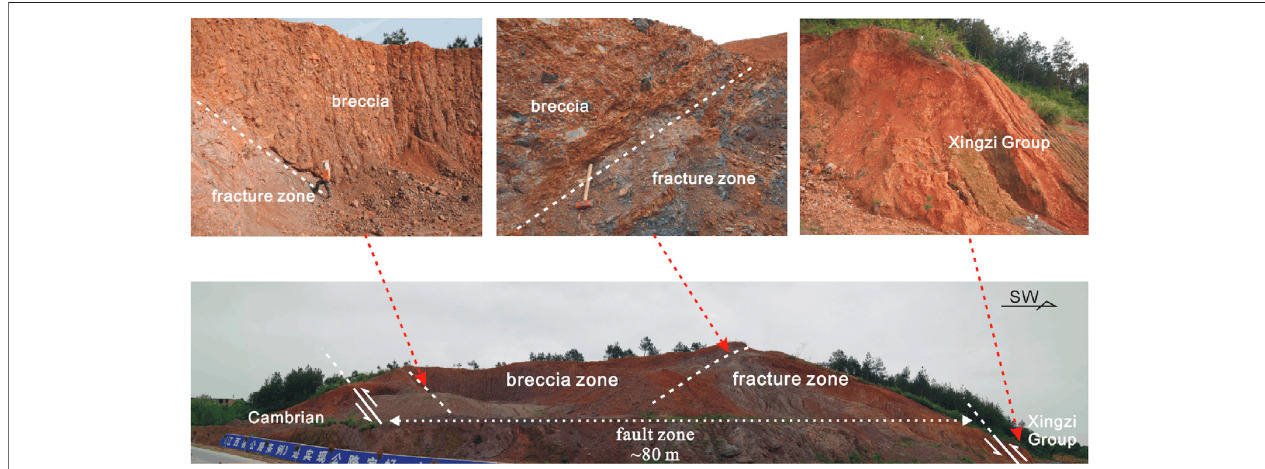
FIGURE5| TheDaaopro fi leshowstheXingzireversefault,whichactsastheeasternboundaryfaultofLuMountain.Thefaultzoneisactuallyabrecciazonewitha visible width of approximately 300 m. The Xingzi Group overrides the fault zone.